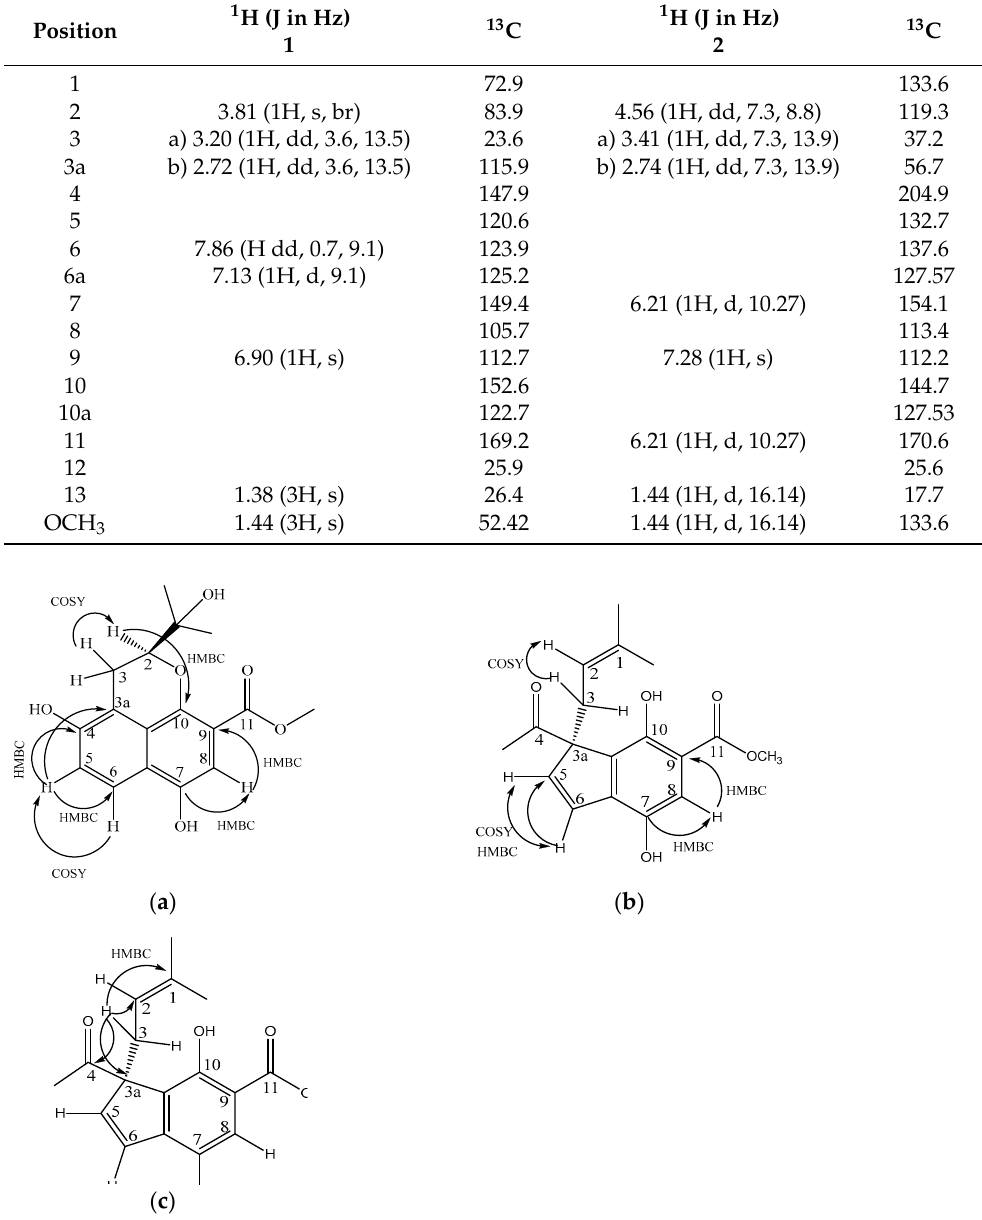
Figure 3. Correlations of ternifoliol and ternifolial 1 H, 13 C (HSQC) and 1 H, 13 C (HMBC) 1 H ( COSY ) NMR (CDCl 3 , 600MHz): ( a ) HMBC and COSY ternifoliol; ( b ) COSY ternifolial; ( c ) HMBC